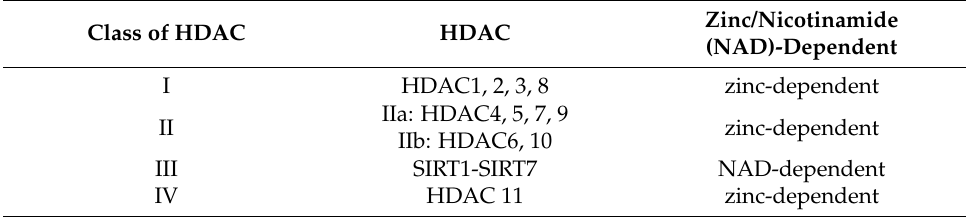
Figure 2. Histone acetylation modifying enzymes (HAT histone acetyltransferase, HDAD-histone deacetylase) control the transcription process by changing the status of histone acetylation and conformation of chromatin [38]. Table 1. Classification of histone deacetylases (HDACs)